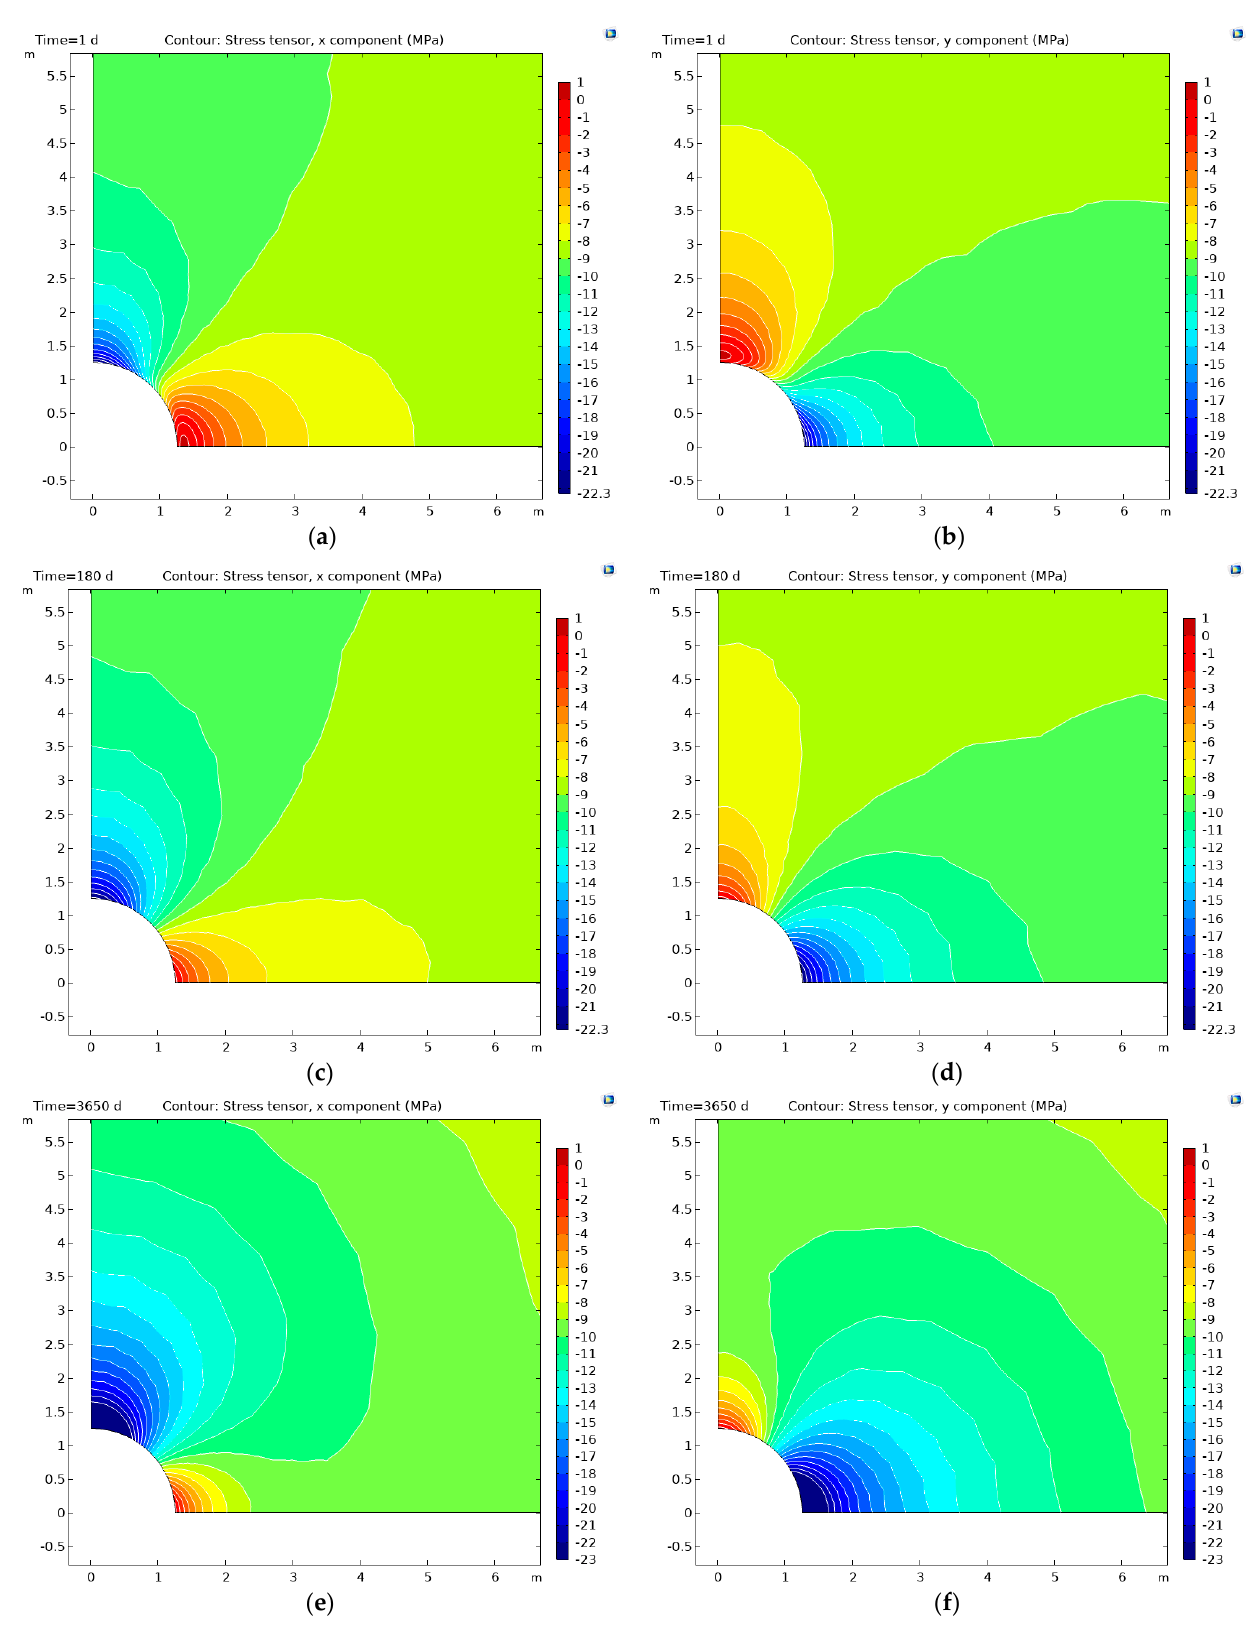
Figure 8. DC variant: distribution of effective stress (x and y components) in the case of isotropic stress conditions and isotropic properties, ( a , b ) by the end of the excavation phase, ( c , d ) by the end of the waiting phase, ( e , f ) by the end of the heating phase.